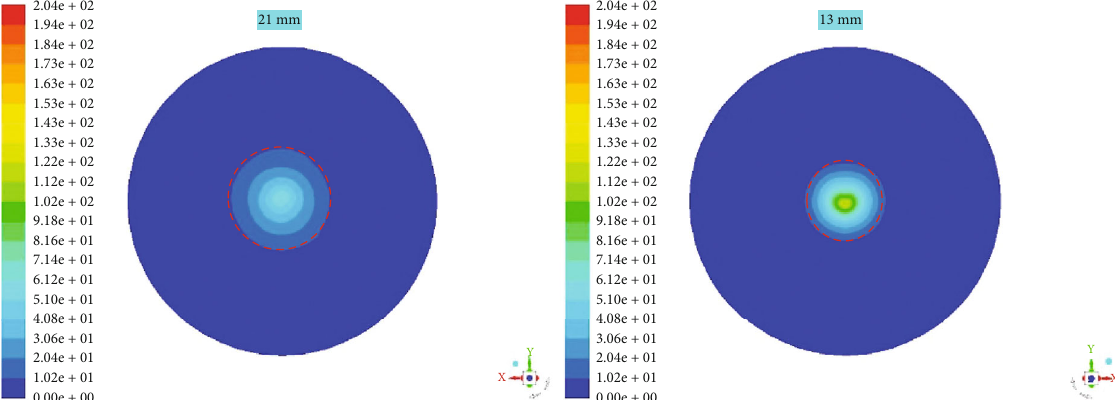
Figure 5: Cloud picture of bottom impact velocity of swirling abrasive jet and direct